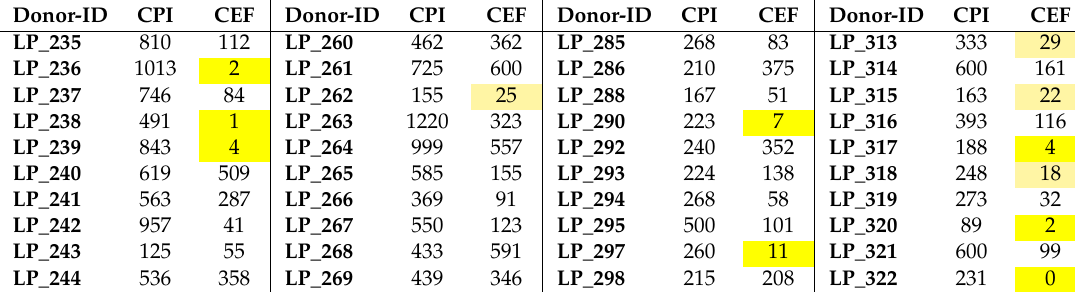
Table 1. CEF peptide negative PBMC donors also respond to CPI. The CEF and CPI-induced recall response is shown for the specified 40 donors randomly selected from the total of 245 tested. Mean SFU counts for three replicate wells are shown. The medium background was less then 10 SFU for all donors (not shown). Negative recall response to CEF are highlighted in yellow, weak responses (that do not qualify for a positive control) are in light